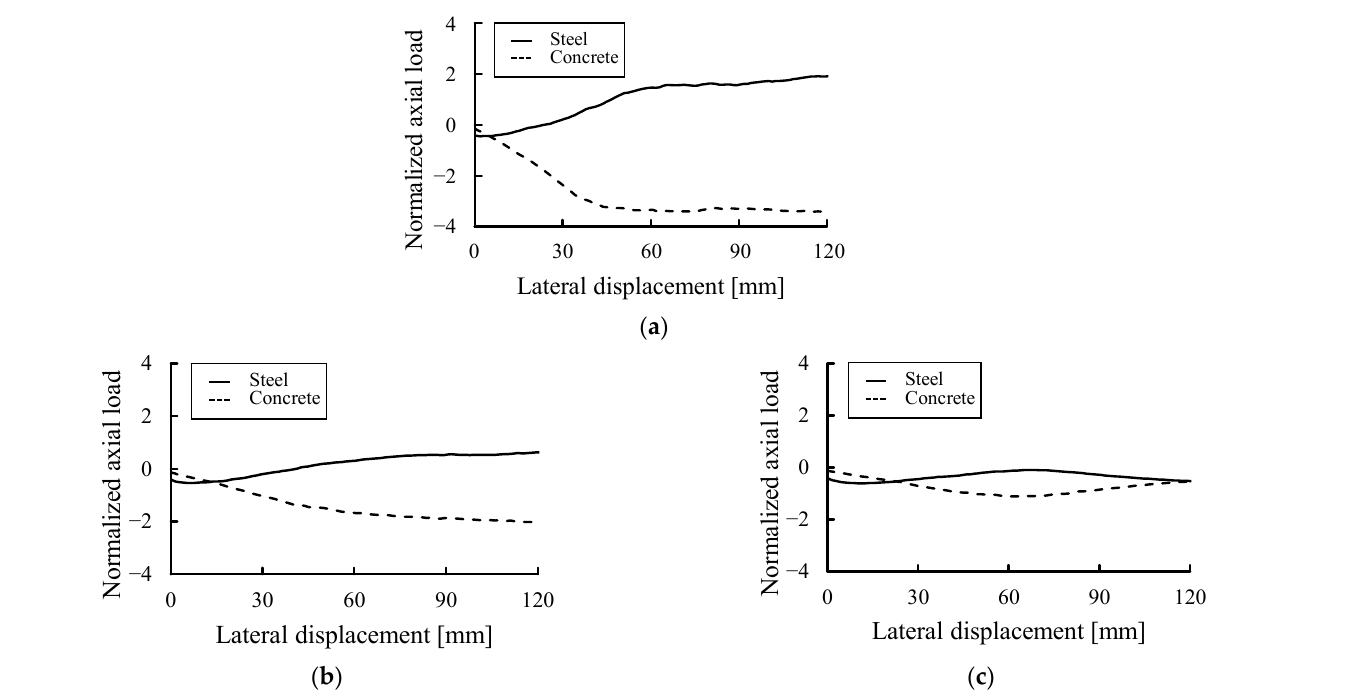
Figure 10. Normalized axial load versus lateral displacement (C-009-030, L c / L = 0.4): ( a ) n = 0.1; ( b ) n = 0.2; ( c ) n =